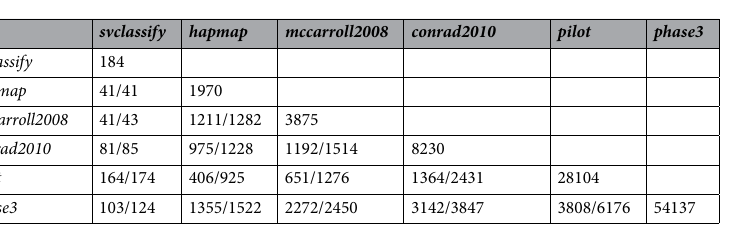
Table 2. Pairwise comparison of sets with validated non-CNV exons and the GIAB high-confidence CNV set ( svclassify ): elements on the main diagonal indicate the set size, for other elements the denominator of a fraction is the number of shared exons in the sets and the numerator is the number of exons with the same state.